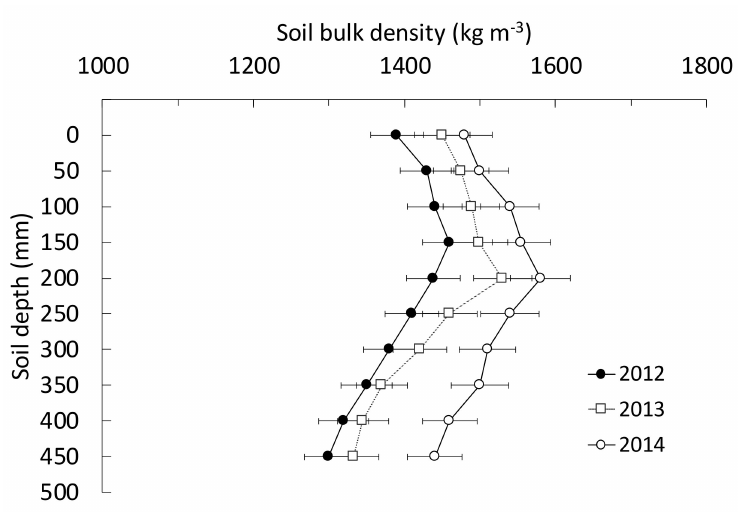
Figure 2. Soil bulk density recoded at the site on seeding days in 2012, 2013, and 2014. Error bars on mean datapoints ( n = 10) denote standard deviation; p < 0.05 (depth) and p > 0.05